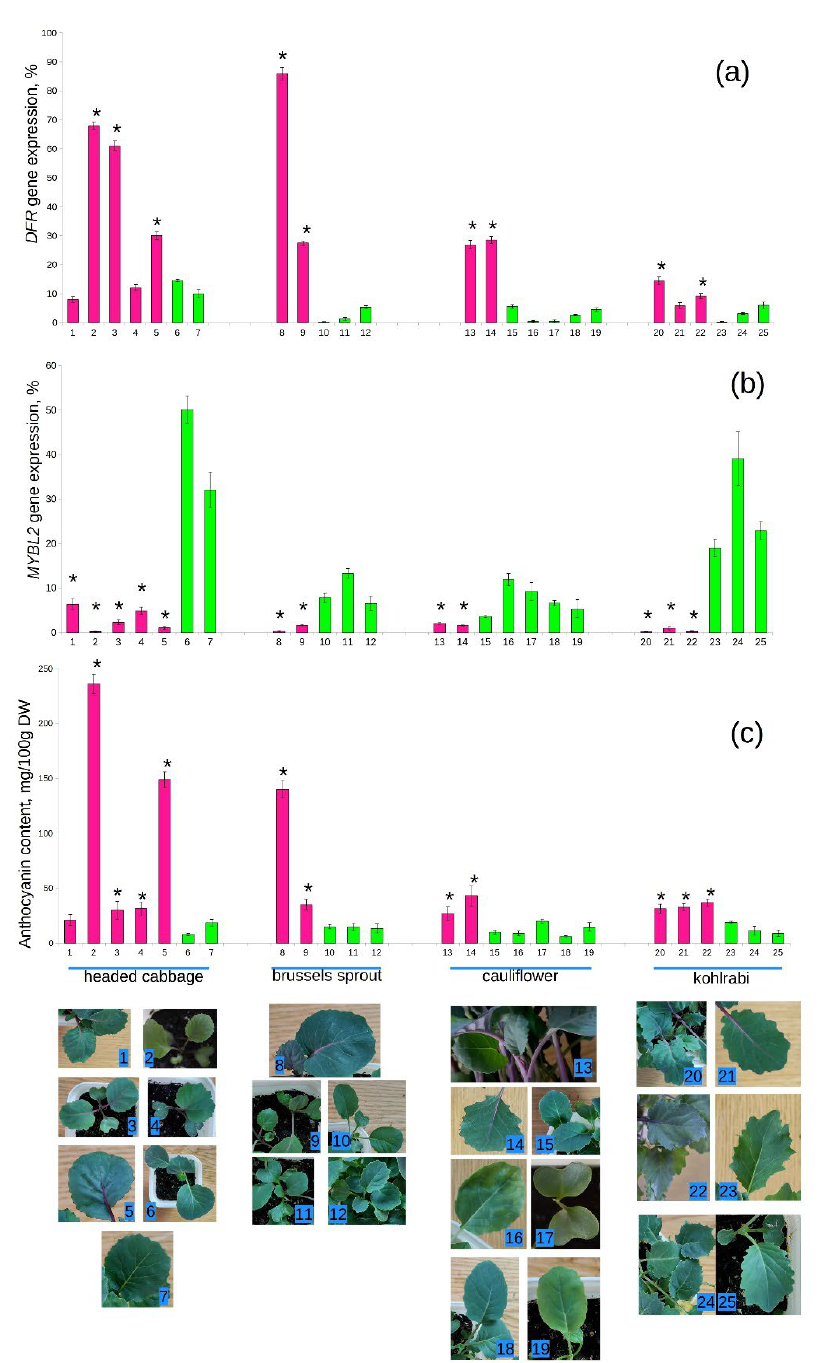
Figure 1. Relative expression level of the DFR gene ( a ), MYBL2 gene ( b ), and anthocyanin content ( c ) in purple and green cultivars of B. oleracea . Visible pigmentation is shown in the photographs. Cultivars are numbered as follows: 1—Kalibos; 2—Ludmila; 3—Ruby; 4—Mars; 5—Firebird; 6—Royal Vantage; 7—Moscow Late; 8—Garnet bracelet; 9—Bunch of grapes; 10—Rosella; 11—Hercules; 12—Sapphire; 13—Gardener’s dream; 14—Purple ball; 15—Bird’s milk; 16—Baby; 17—Flame star; 18—Green bunch; 19—Alpha; 20—Madonna; 21—Violetta; 22—Vienna purple; 23—Vienna white; 24—Gulliver; 25—Picante. Varieties declared as purple are highlighted in pink. Asterisk (*) indicates a significant difference from unpigmented plants of the same cultivar.